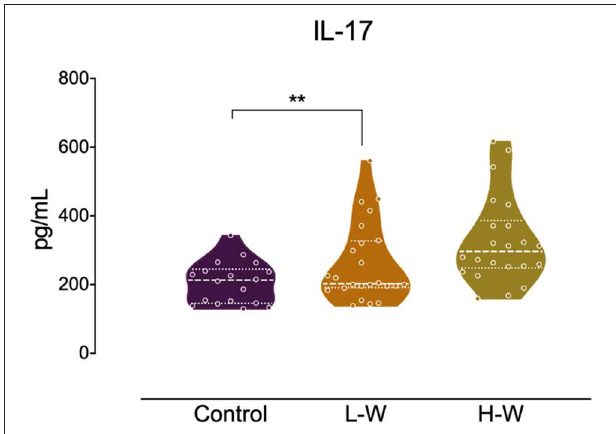
FIGURE 3 | Th-17 related cytokine after in vitro stimulation in women with CUD and healthy controls. PBMCs were seeded in 96-well plate and stimulated with phytohemagglutinin (1%) for 72h. Cell supernatants collected from L-W group had higher levels of IL-17 than controls. Kruskal–Wallis test was carried out to compare statistical differences. Data are shown as median with interquartile range. Statistical significant group differences are indicated. ** p < 0.01.